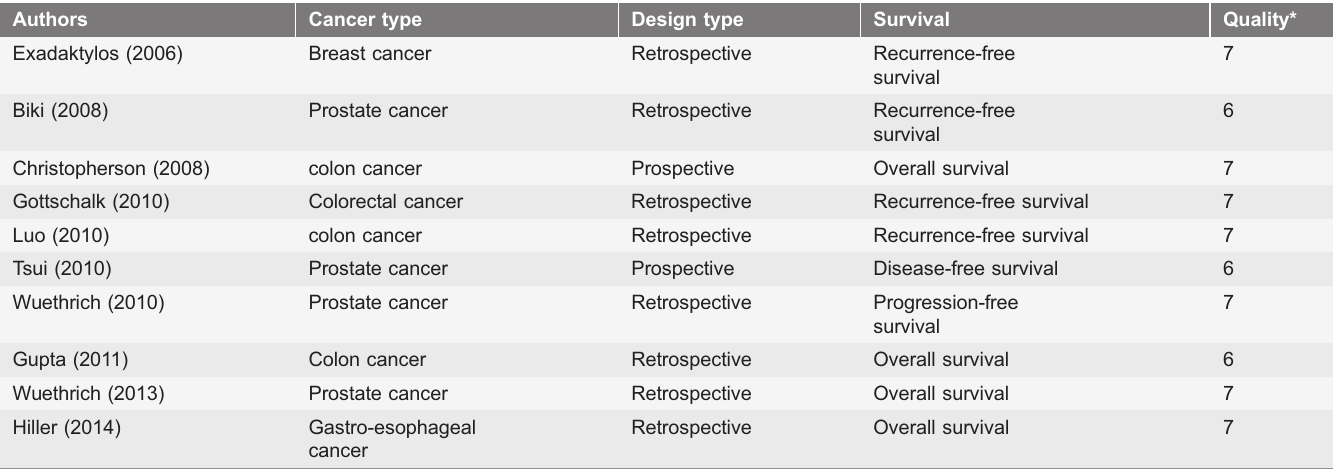
Table 1. Basic characteristics of included studies.